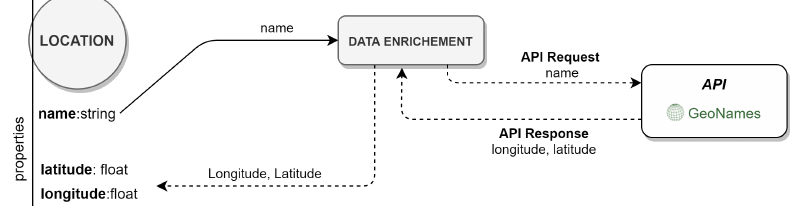
Figure 6. Enrichment Data